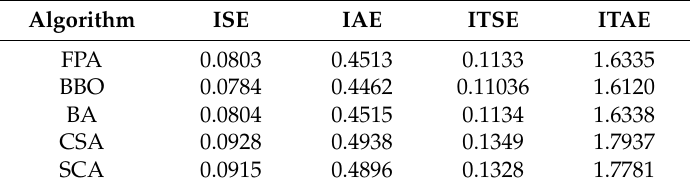
Table 6. Performance indices of PI controllers tuned using BA, BBO, CSA, FPA and SCA in case 2.